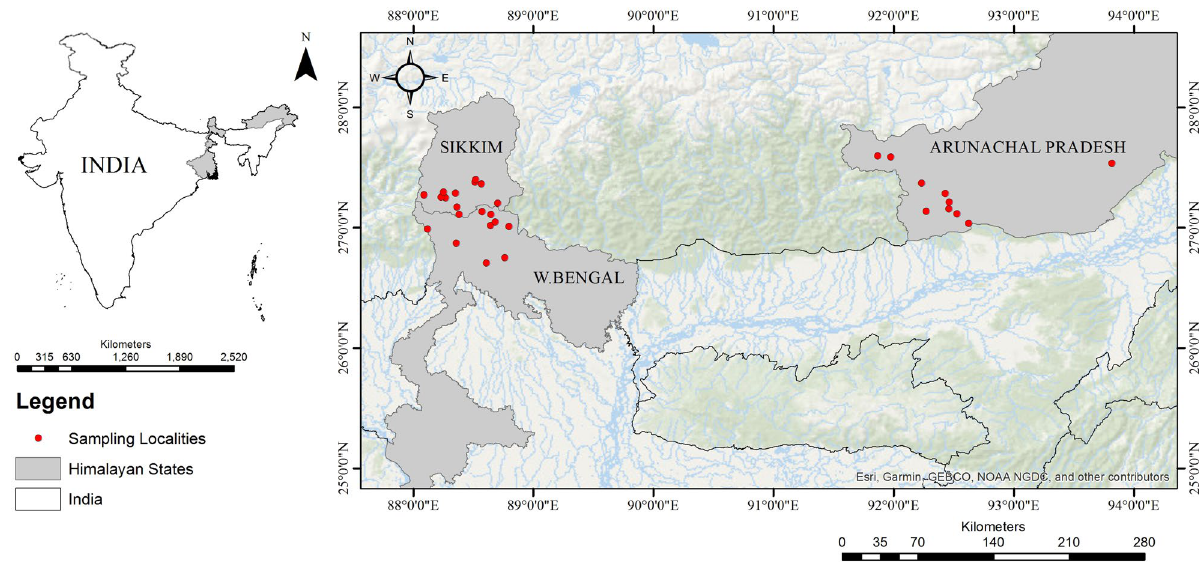
Figure 7. Localities sampled in this study (ArcGIS version 10.5, URL: https:// www. arcgis. com/ index.